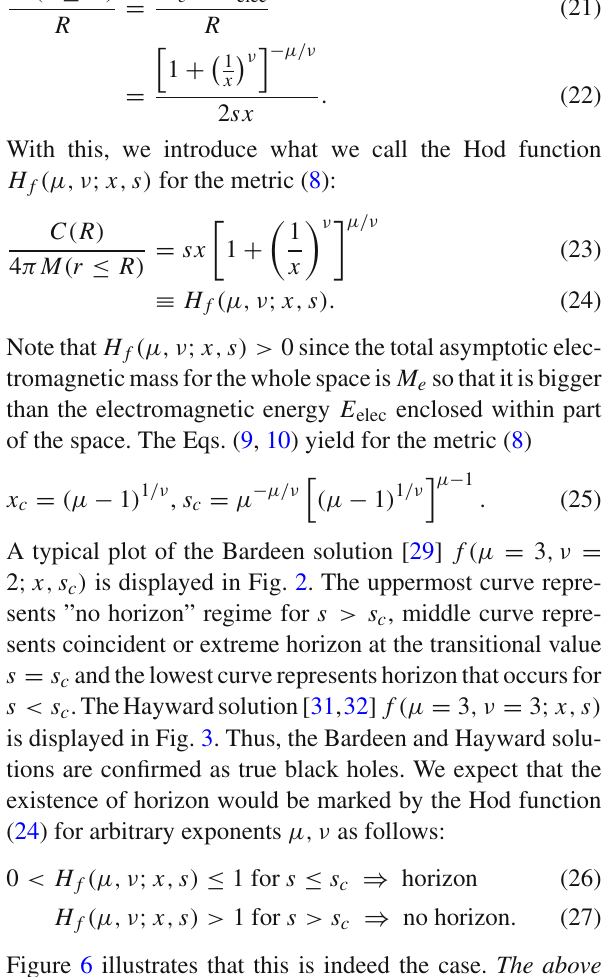
M ( r ≤ R ) contained within ( r ≤ R ) of the ball is given